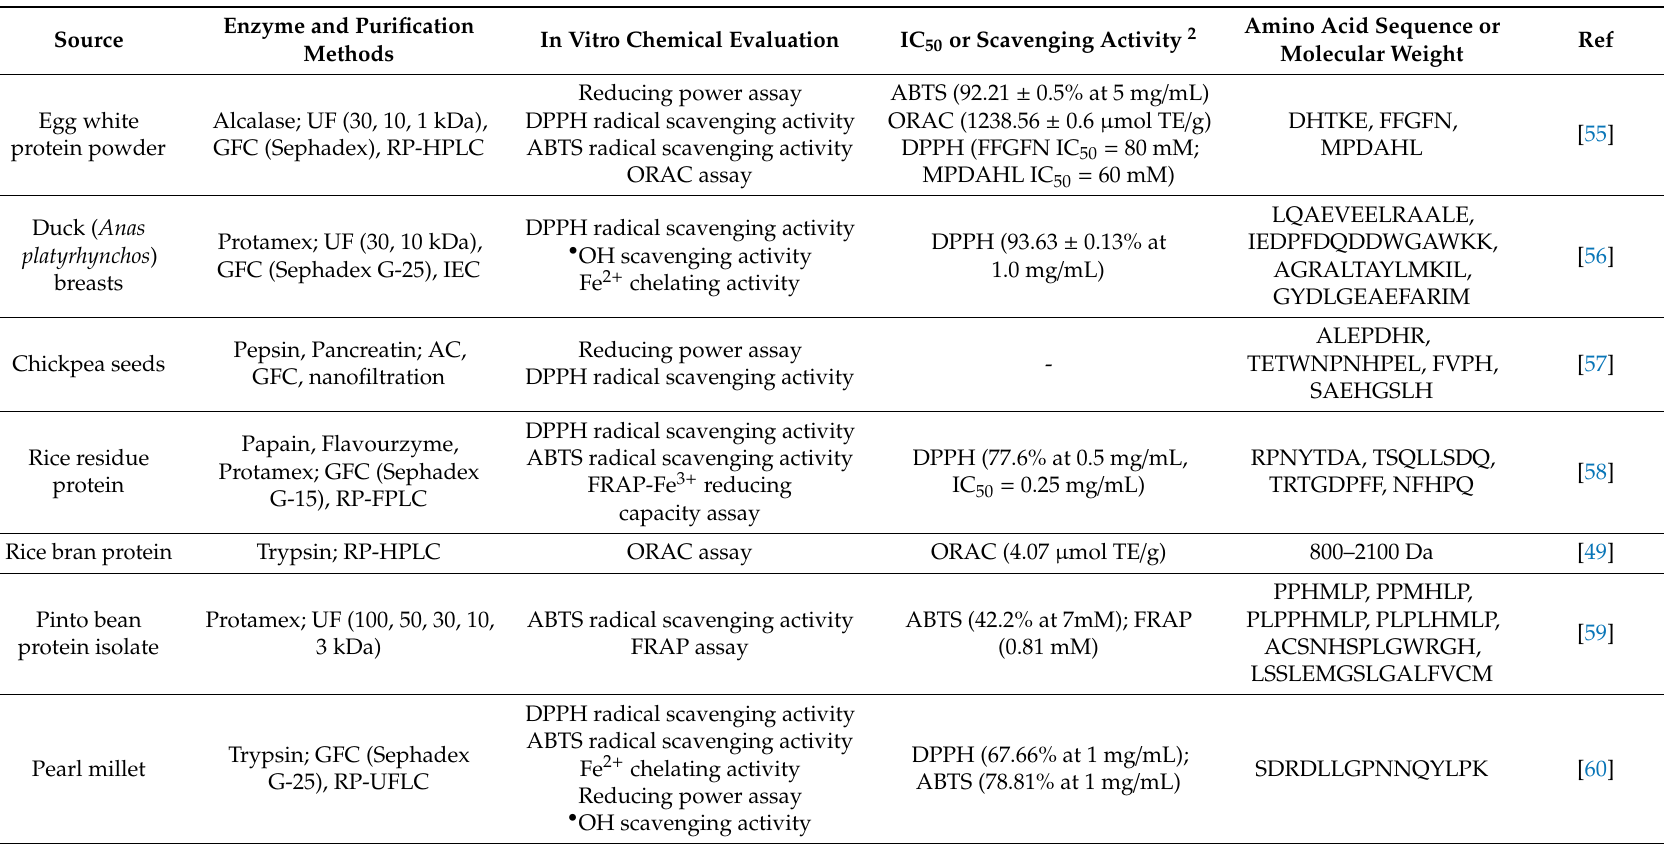
Table 1. Enzymes used for the preparation of food protein hydrolysate, the methods of purification, and the evaluation of antioxidant capacity 1